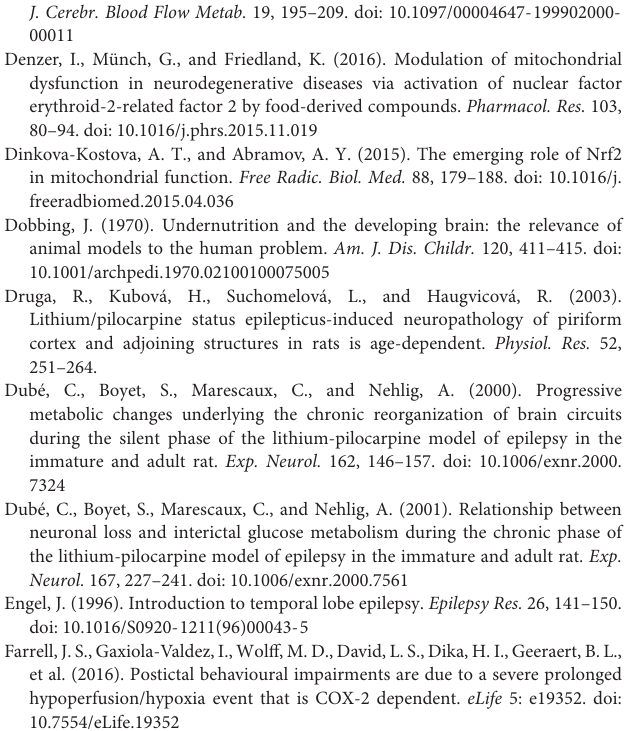
Supplementary Figure 1 | (A) EEG activity during Li-Cl Pilo status epilepticus has been determined as the number of epileptic spikes in 60 s bins. Time zero is the time of pilocarpine application. Red line, convulsant agent alone ( n = 6); Blue line, convulsant agent plus SFN ( n = 5). (B) A total number of detected epileptic spikes during 90 min of SE duration was not influenced by SFN suggesting no anticonvulsant effect ( P = 0.67). Latency to start of behavioural SE after pilocarpine application also did not differ between the groups P = 0.76. EEG was recorded from silver epidural electrodes placed above the sensorimotor cortex. Epileptic spikes were detected using Spike2 software (CED, United Kingdom) and analysed in Matlab (Mathworks, Nattick, MA, United